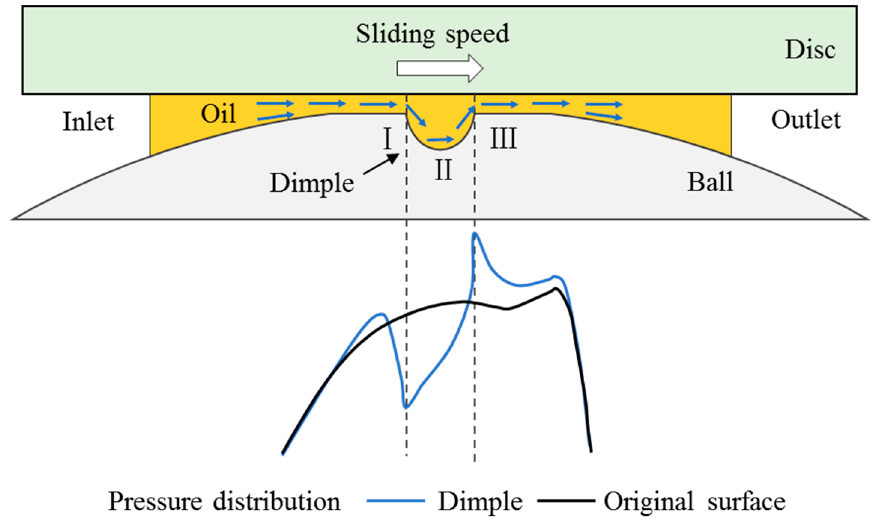
Figure 12. Schematic of the process of lubricating oils flowing through the